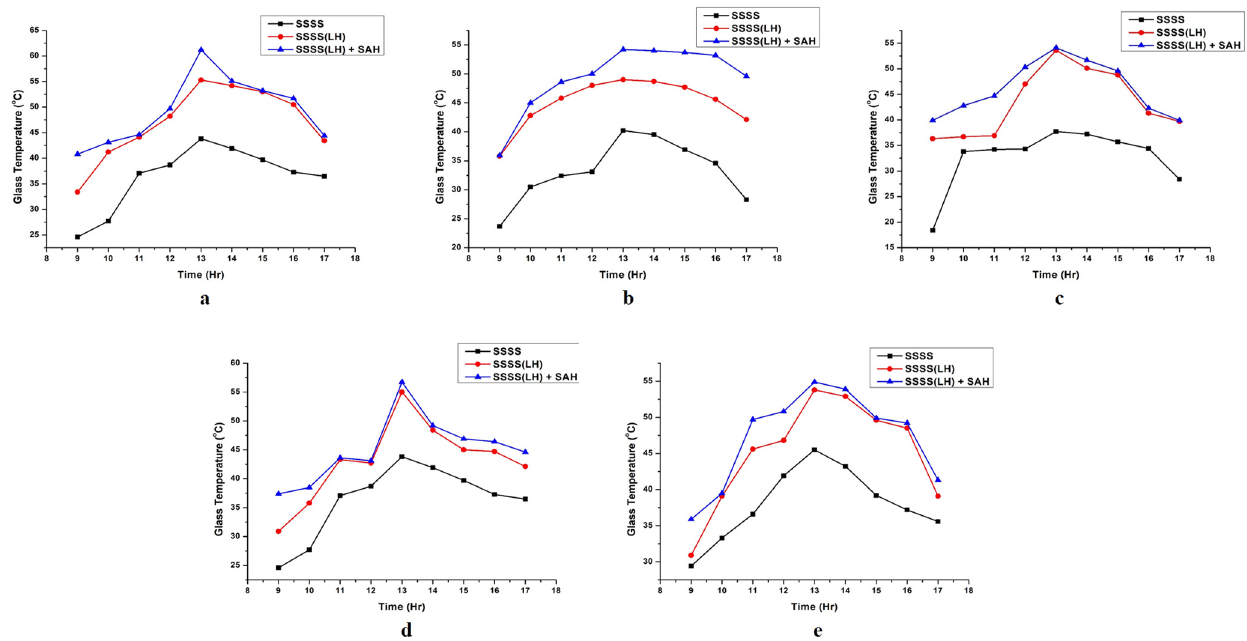
Figure 5. ( a – e ) Variation of glass temperature vs. time at the depth of 3 cm, 6 cm, 9 cm, 12 cm, and 15 cm, respectively.